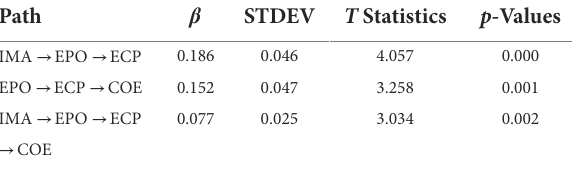
TABLE 4 Assessment of mediation effect. Path β STDEV T Statistics p